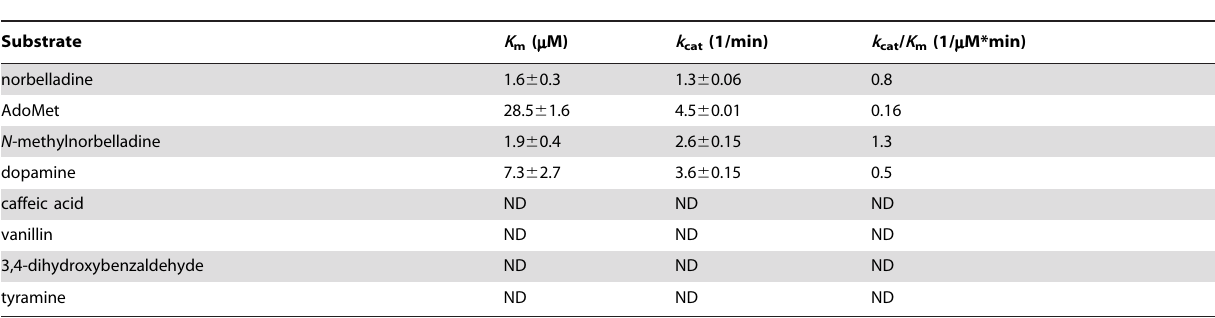
Table 1. Substrate specificity of Np